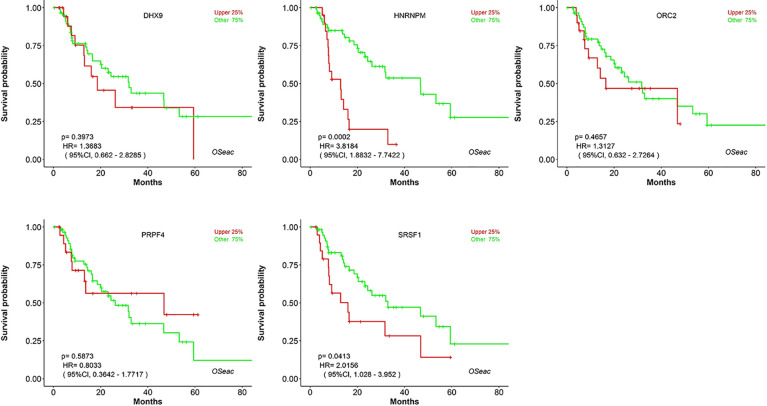
The prognostic value of hub genes in BE and EAC patients (Kaplan–Meier plot).